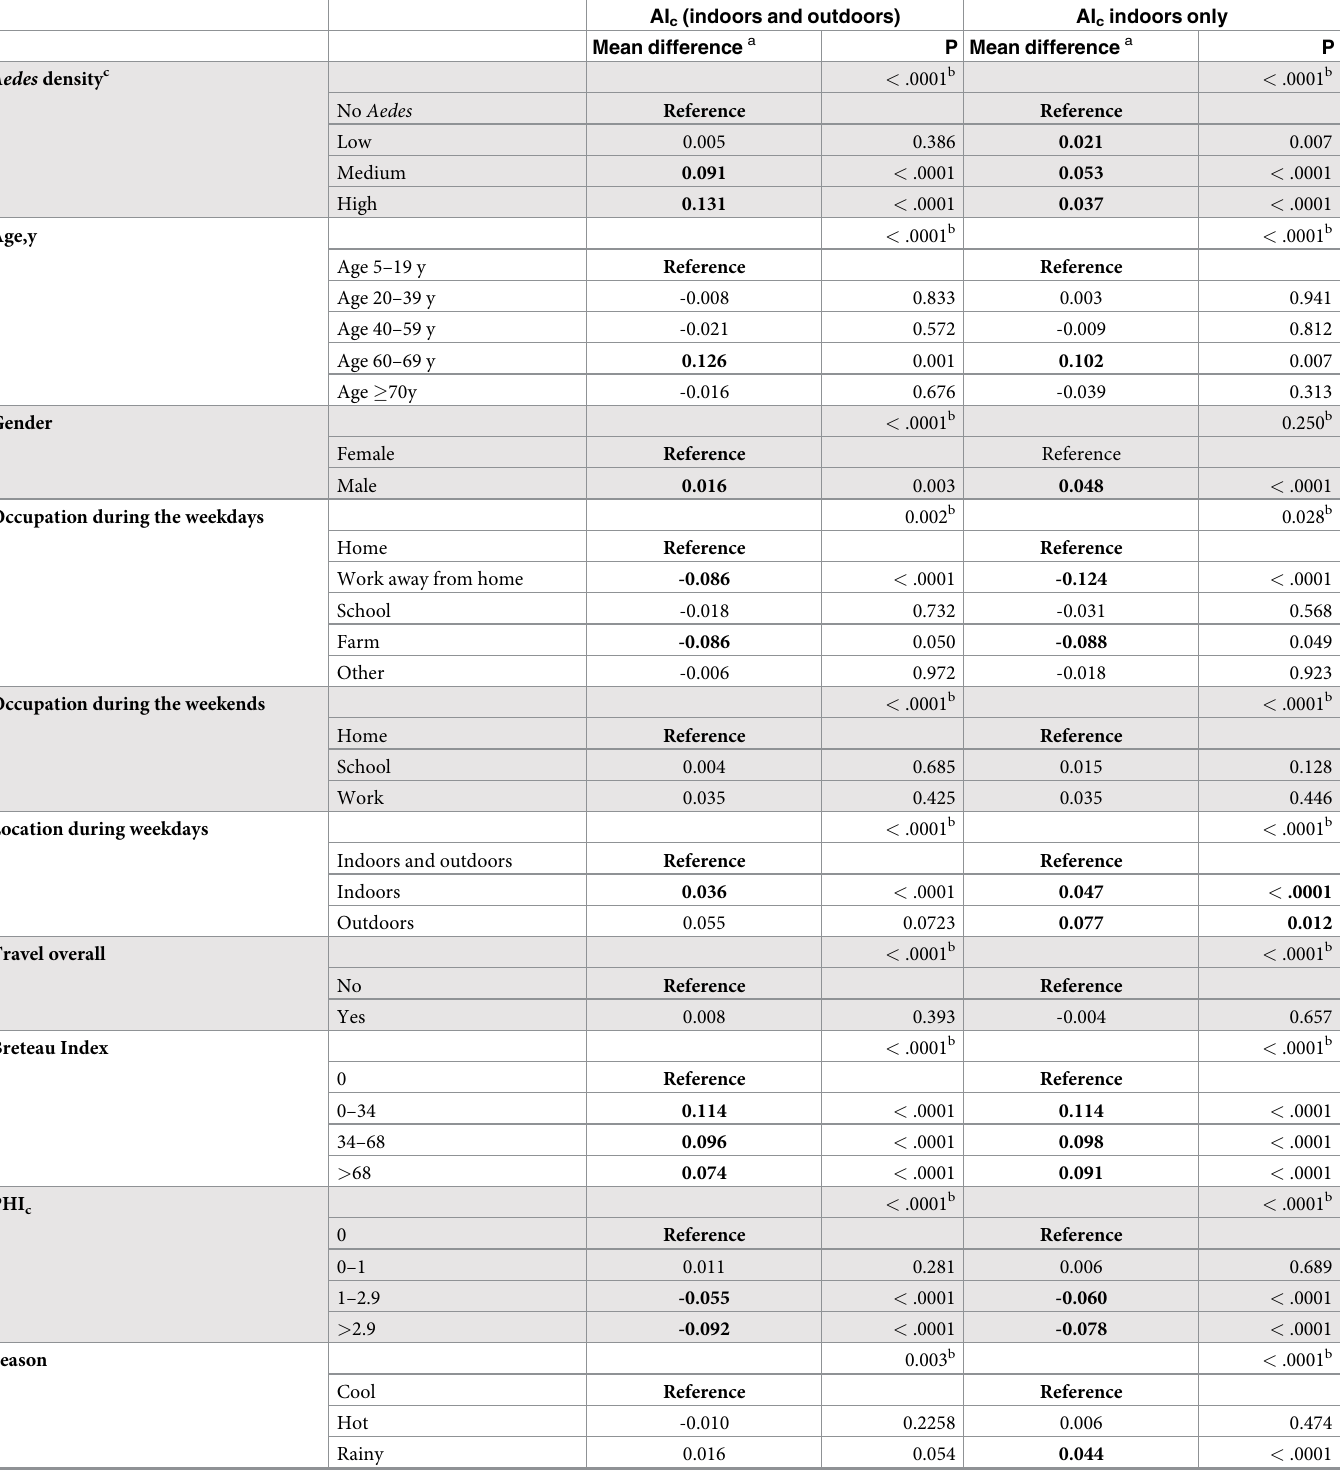
Table 4. Multivariate analysis of MEI, human immune response to Nterm-34 kDa salivary